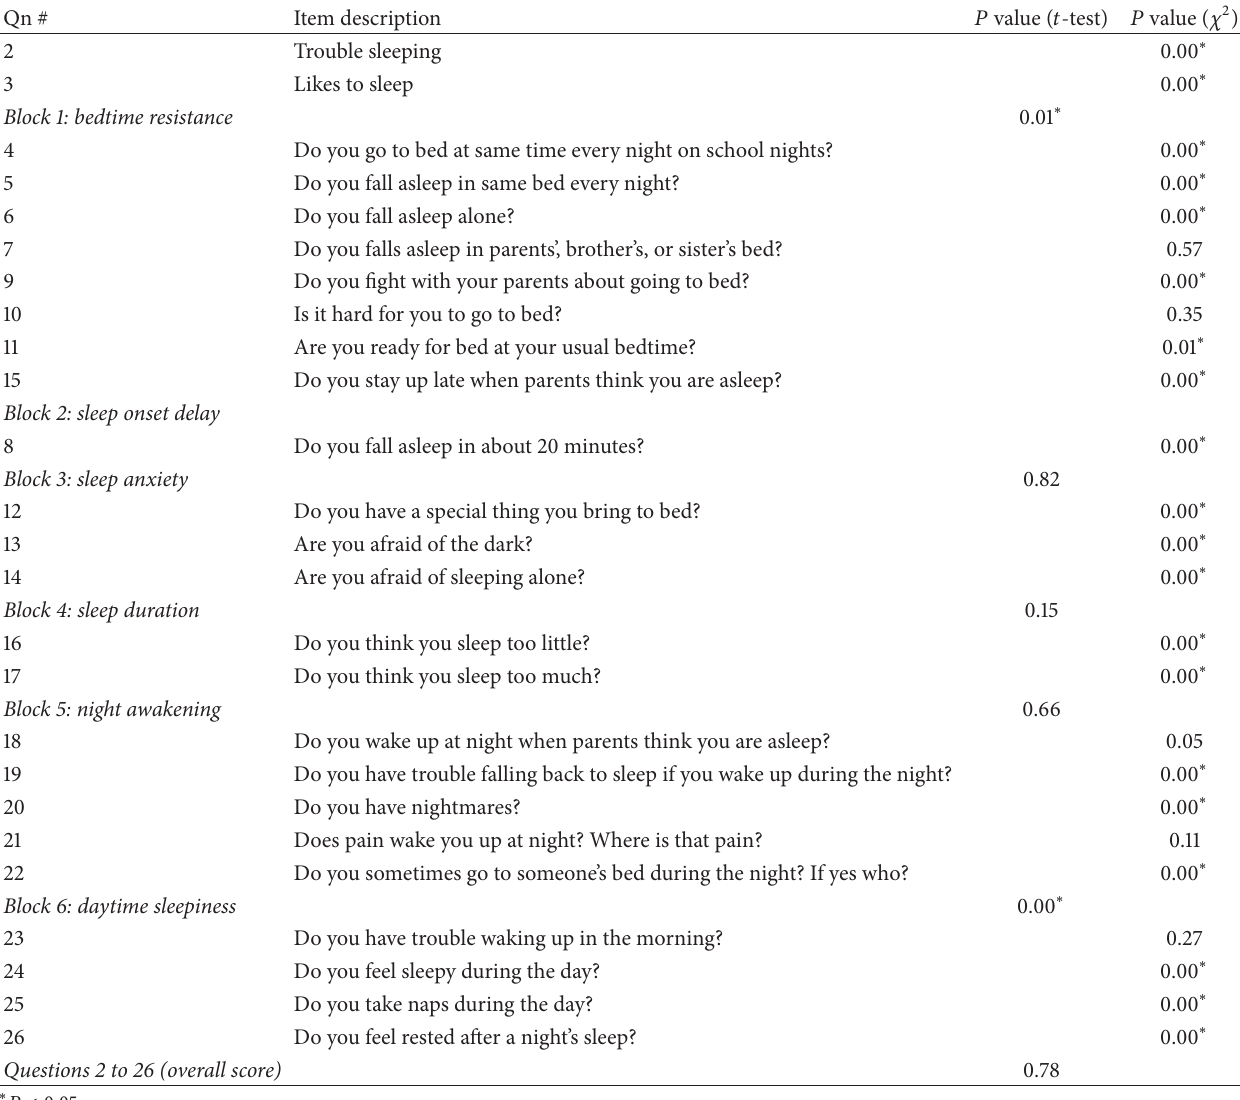
Table 4: Comparisons of sleep habits between elementary and middle school